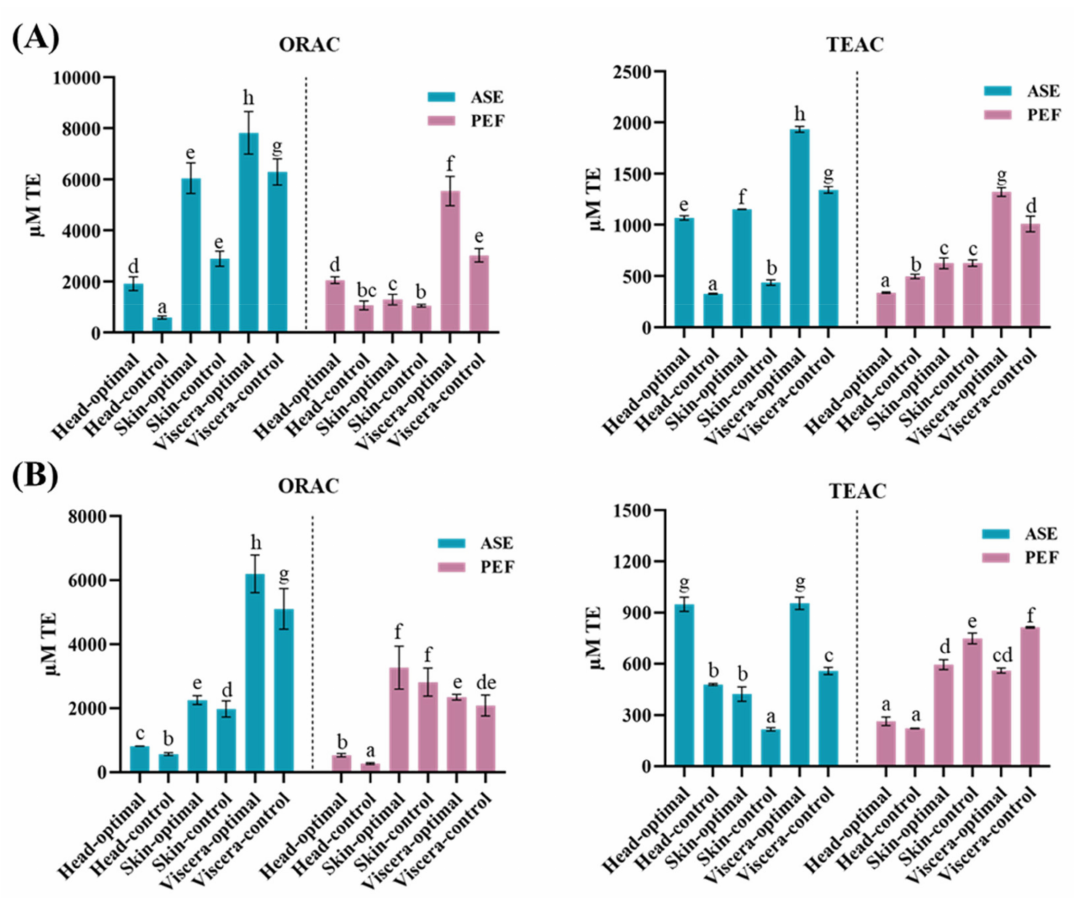
Figure 2. Total antioxidant capacity (ORAC and TEAC) in the control and optimal PEF/ASE-assisted extracts from fish by-products. ( A ) rainbow trout and ( B ) sole; PEF: pulsed electric fields; ASE: accelerated solvent extraction; Different lowercase letters (a–g) in the figure indicate statistically significant differences ( p < 0.05). ORAC: oxygen radical absorbance capacity; ABTS: ABTS + scavenging